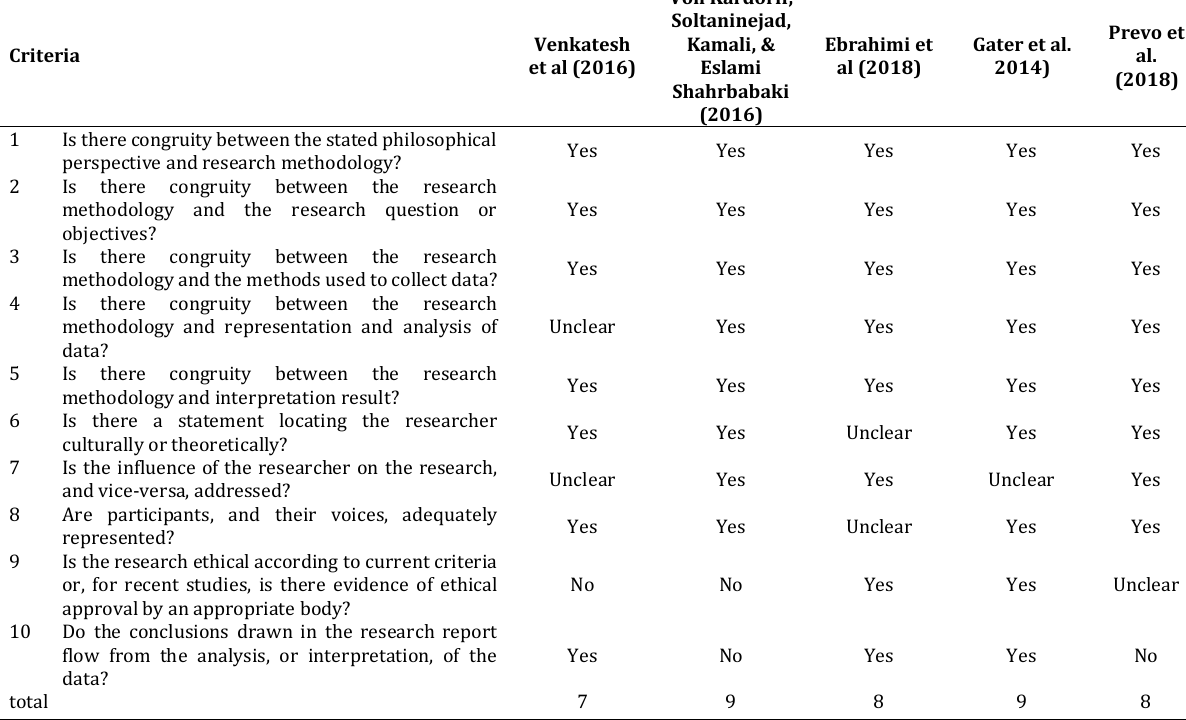
Table 1. Joanna Briggs Institute- check list for qualitative research (Continue)